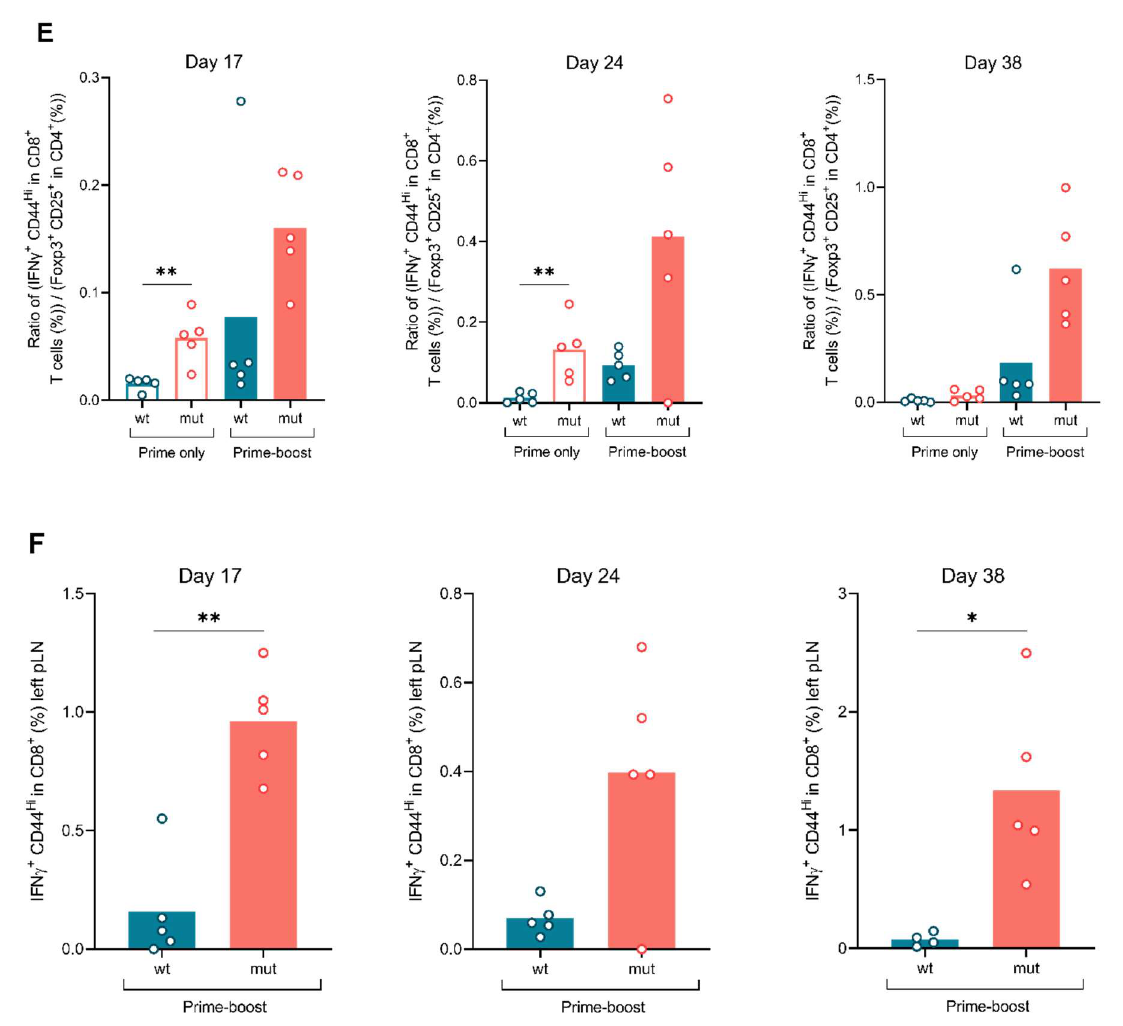
Figure 3. ISDmut vaccines elicit stronger CD8 + T cell responses both locally and systemically. ( A ) Schematic representation of the vaccine regimen. BALB/c mice were vaccinated s.c. (right paw) on day 0 with either the Ad19a/64-ERV ISDwt or the Ad19a/64-ERV ISDmut vaccine. Half of the primed mice were vaccinated s.c. (left paw) a second time (boost) with either the Ad5-ERV ISDwt or with the Ad5-ERV ISDmut on day 7, 14 or 28. Spleens and vaccine-draining pLN (at the site of booster injection) were collected 10 days after the boost to perform ICS against the MelARV Env gp70/SU H2-Ld-restricted T cell peptide AH1. ( B – D ) Immune profiling of spleens in Ad19a/64 +/− Ad5-ERV ISDwt- or ISDmu-vaccinated mice. Frequency ( upper graphs ) and absolute number ( bo(cid:308)om graphs ) of IFNγ + CD44 Hi CD8 + T cells responding to AH1 MelARV peptide at day 17, 24 and 38 post prime. Day 17 was repeated in two independent experiments. ( E ) Ratio of the percentage of IFNγ + CD44 Hi in CD8 + T cells and the percentage of FoxP3 + CD25 + in CD4 + T cells (T regs ) in the spleen of prime-boosted mice. ( F ) Immune profiling of draining pLN in prime-boost (Ad19a/64- and Ad5-ERV ISDwt or ISDmut)-vaccinated mice showing the frequency of IFNγ + CD44 Hi CD8 + T cells responding to AH1 MelARV peptide at day 17, 24 and 38 after prime. N = 4–5, *: p < 0.05, **: p < 0.01—Mann–Whitney U test. The gating strategy can be found in Supplementary Figure S4A.